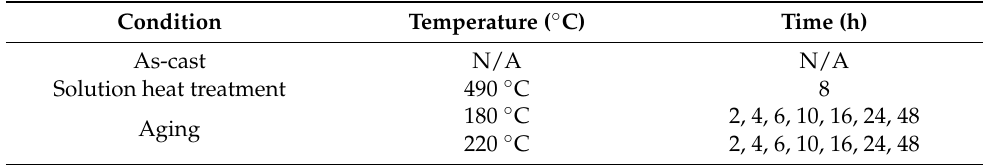
Table 4. Heat treatment conditions applied to tensile test bars.